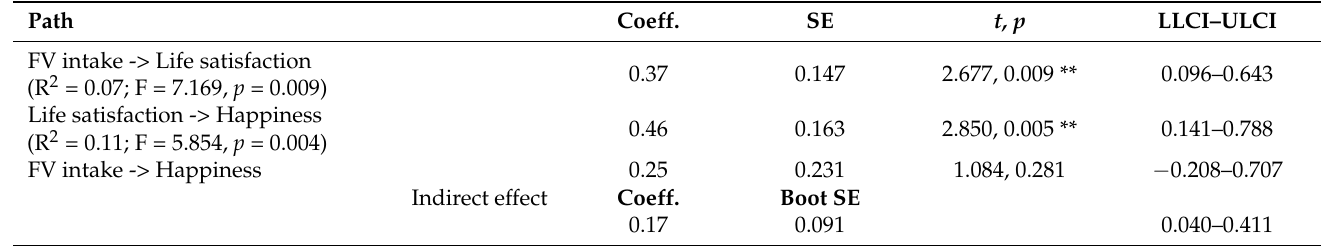
Figure 1. Mediational effect of life satisfaction in the relationship between FV intake and happiness. Note. Standardized coefficients for indirect and direct effects. Note: ** p < 0 .01. Table 5. Indirect mediational